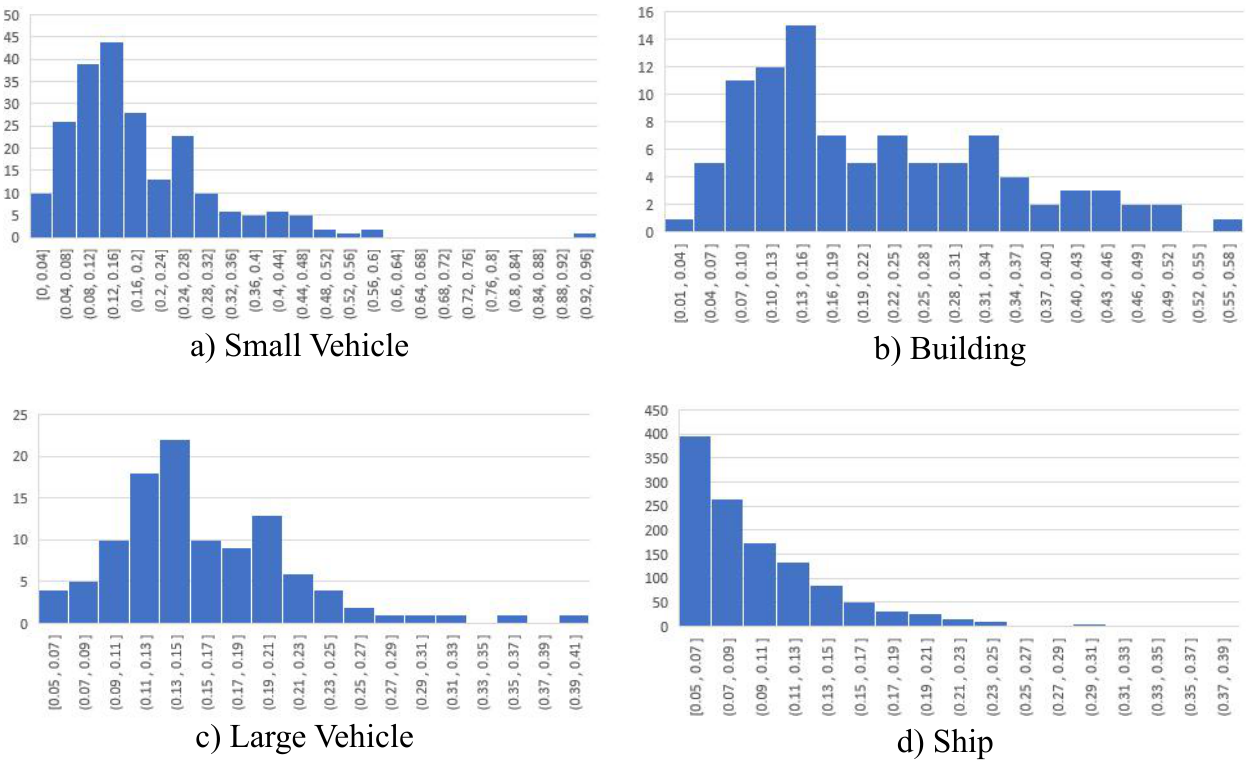
Figure 5. The sample distribution of four objects (i.e., Small Vehicle, Large Vehicle, Building, and Ship) in the RSOC dataset [57], the ordinate represents the number of samples, and the abscissa represent the proportion of pixels of the target object in the sample to pixels of the whole